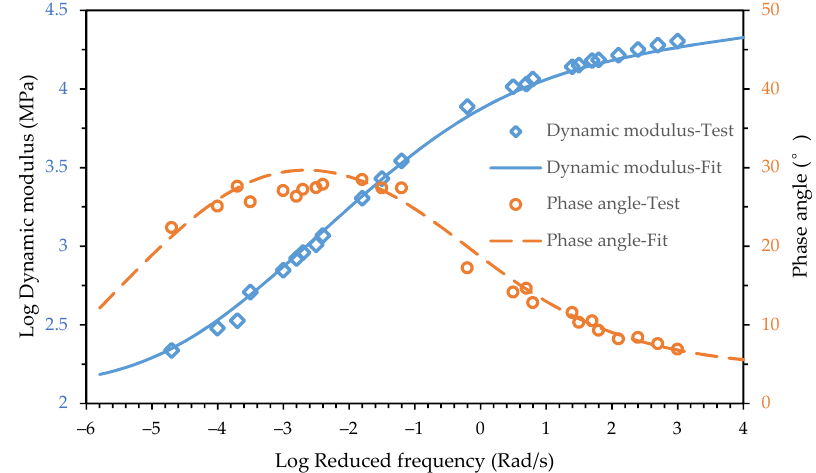
Figure 3. Test data and fitting curve of the asphalt mixture for the dynamic modulus and phase angle.